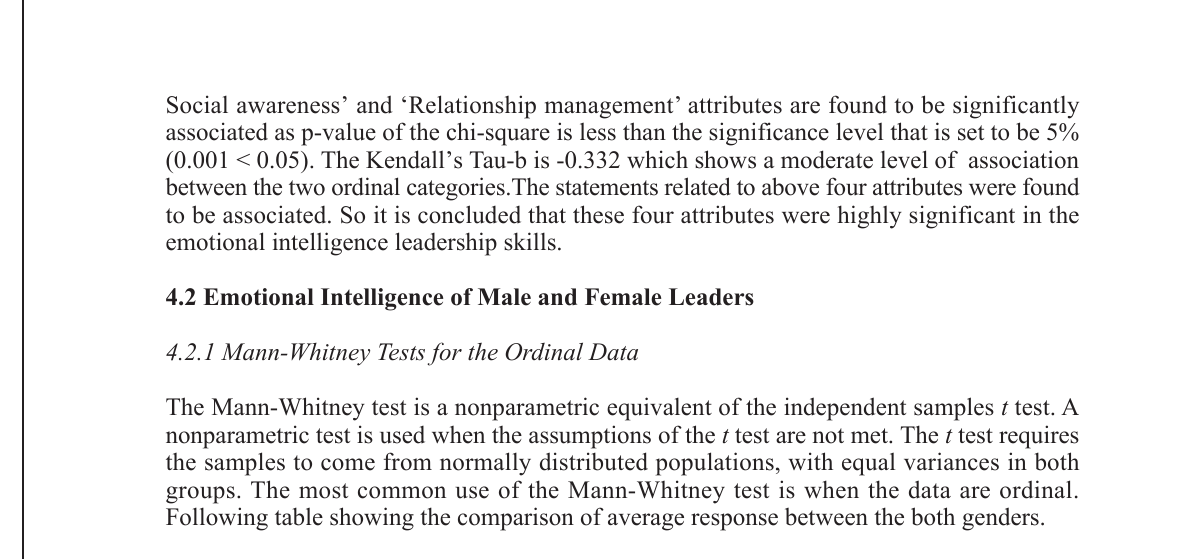
Table 6 Comparison of EmotionalIntelligence Level of Male and Female HoDs SrNo